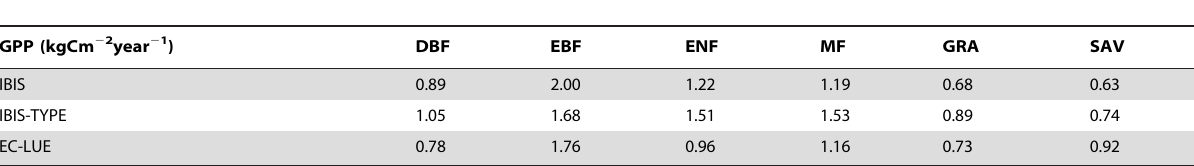
Table 3. The magnitude of gross primary production (GPP) in each plant functional type